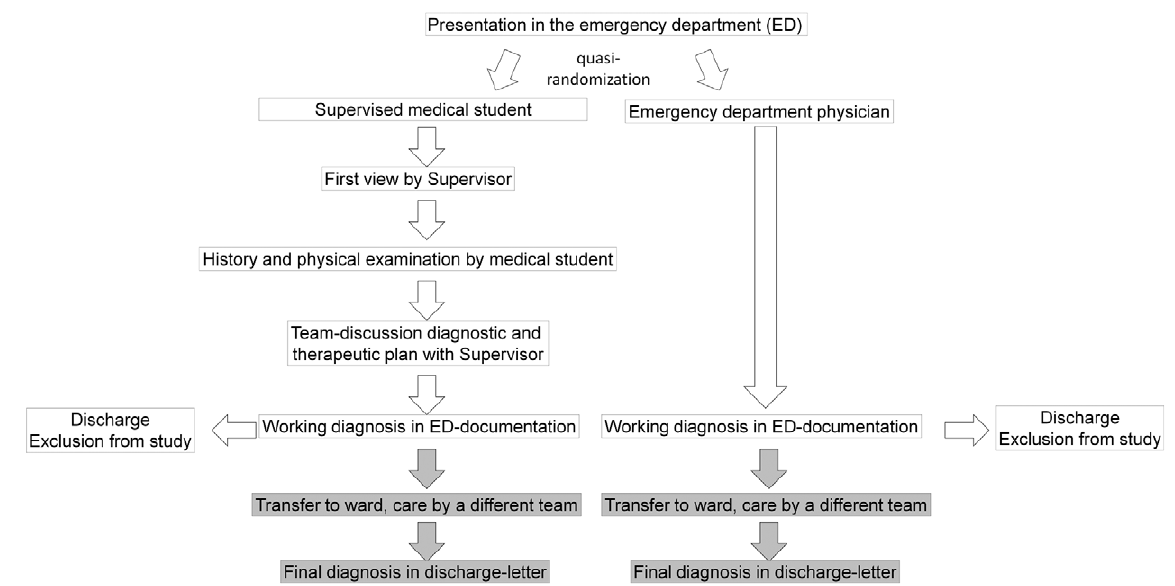
Figure 1. Flow-chart of the study design.